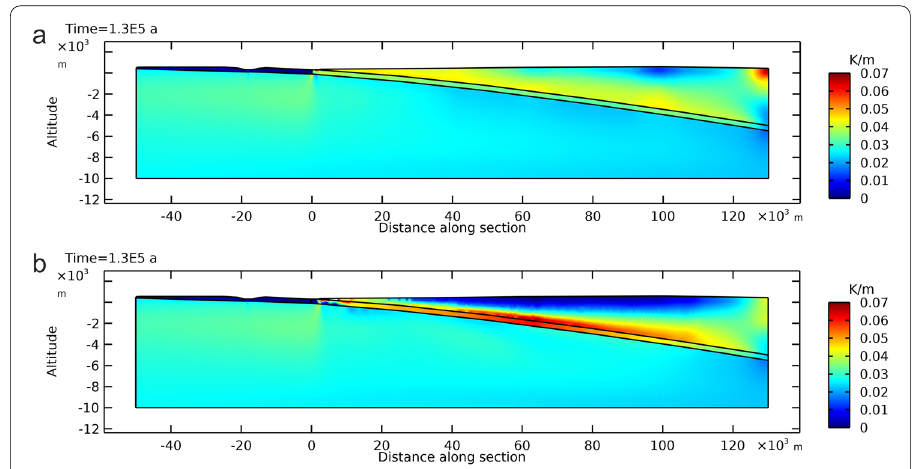
Fig. 13 Geothermal gradient at present (time 1.3E5 a) under paleoclimatic conditions in a the low Malm = permeability scenario (i.e. model run D introduced in Fig. 3), and b the high Malm permeability scenario (i.e. model run E). Vertical exaggeration equals